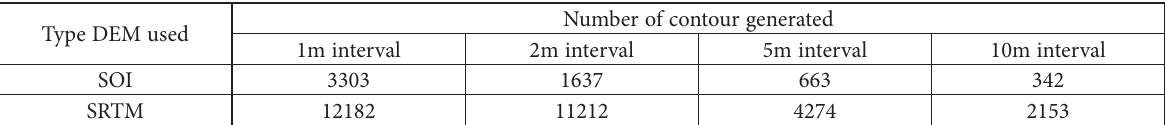
Table 4. Comparison of